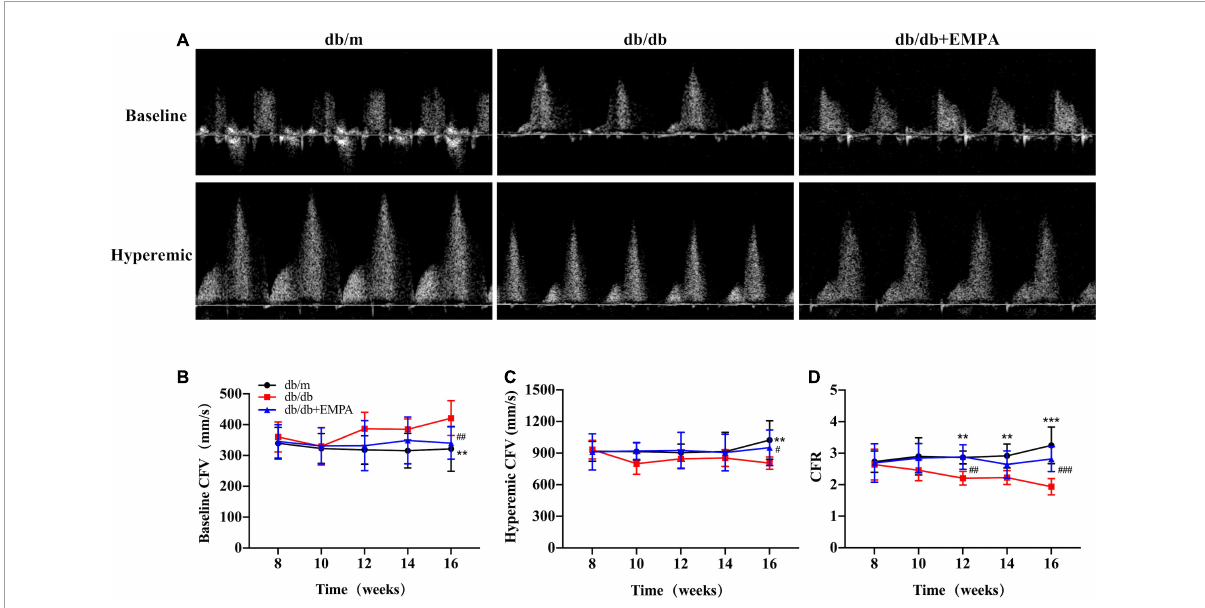
FIGURE3 Empagliflozin inhibited coronary microvascular dysfunction in db/db mice. (A) Representative images of coronary flow velocity (CFV) recording in the mouse coronary artery. (B) Quantitative analyses of baseline CFV of different groups over time. (C) Quantitative analyses of hyperemic CFV of different groups over time. (D) Quantitative analyses of coronary flow reserve (CFR) of different groups over time. CFR was calculated as the ratio of hyperemic and basal coronary flow velocities. Data are presented as the means ± SEM, the db/m group vs. the db/db group vs. the db/db + EMPA group = 6 vs. 9 vs. 11. ** p < 0.01 and *** p < 0.001 the db/m group vs. the db/db group; # p < 0.05, ## p < 0.01 and ### p < 0.001 the db/db group vs. the db/db + EMPA